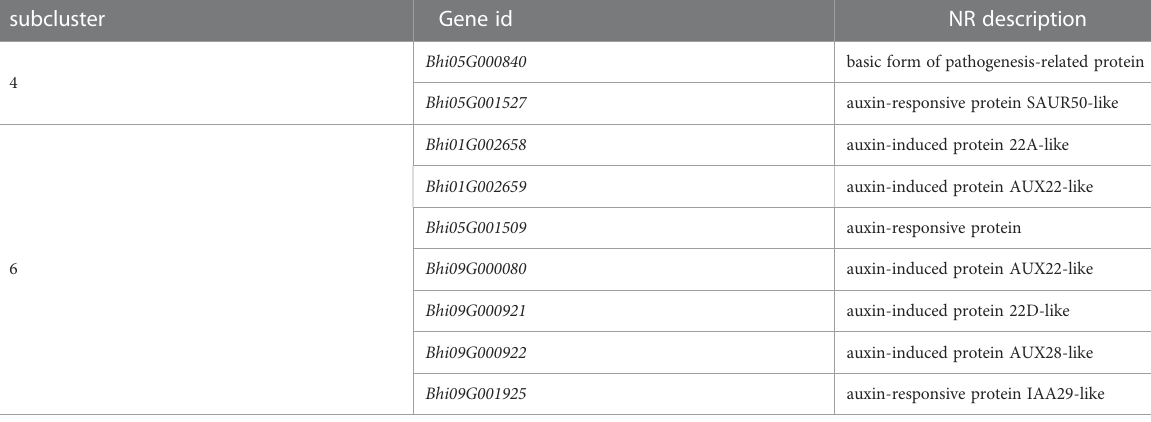
TABLE 4 Genes in subcluster 4 and 6 of plant hormone signal transduction pathway.